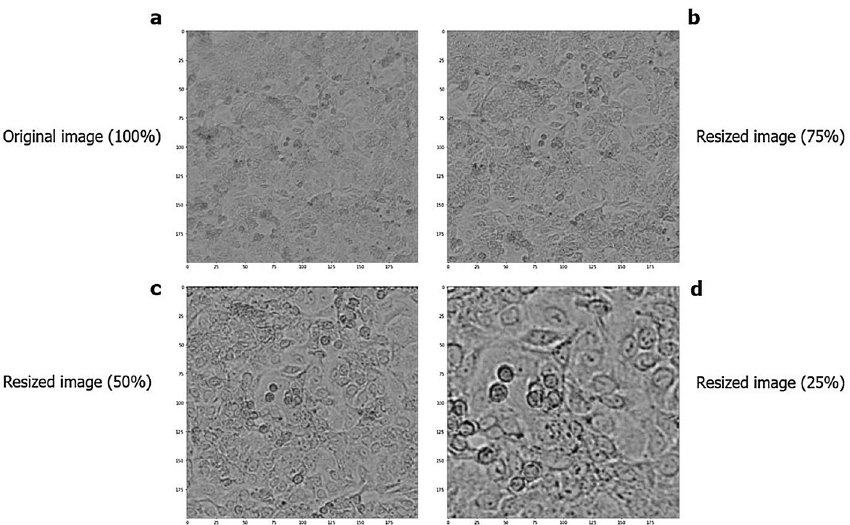
Figure 8. Microscopy images of the A549 cell line in different dimensions. ( a ) Original image. ( b ) Cropping 75% of the image. ( c ) Cropping 50% of the image. ( d ) Cropping 25% of the